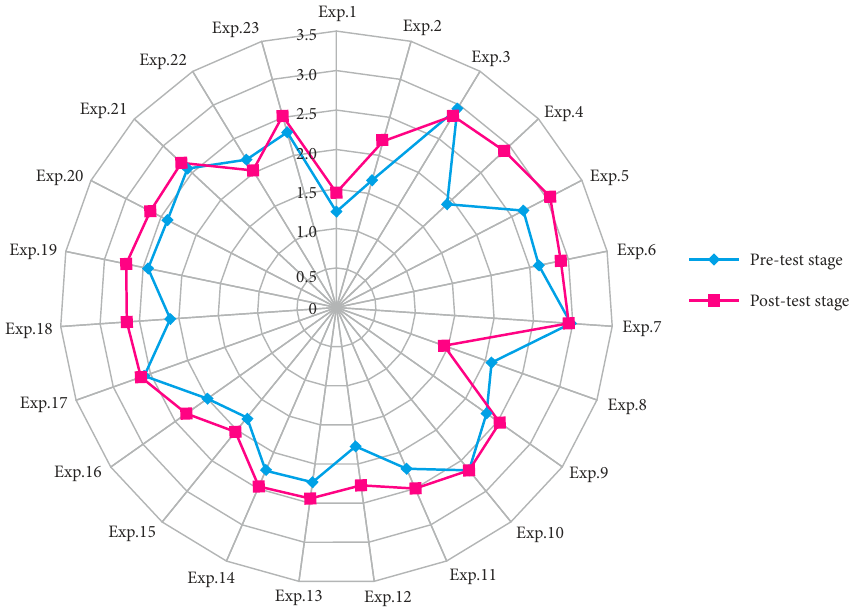
Figure 2. The results of sensitivity